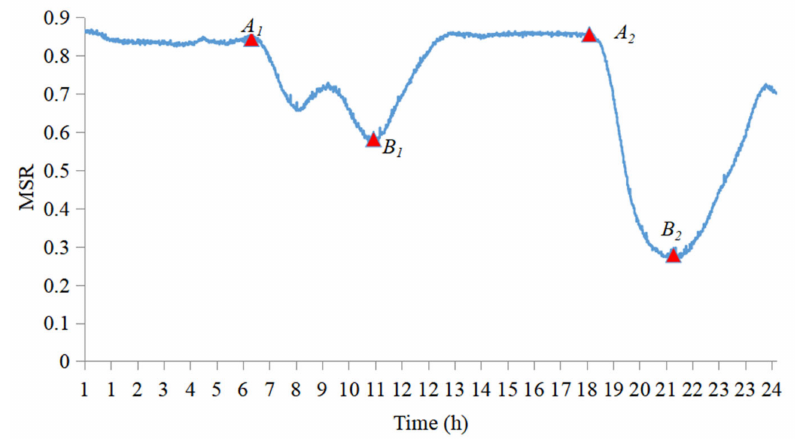
Figure 2. Schematic diagram of net load time division based on MSR.